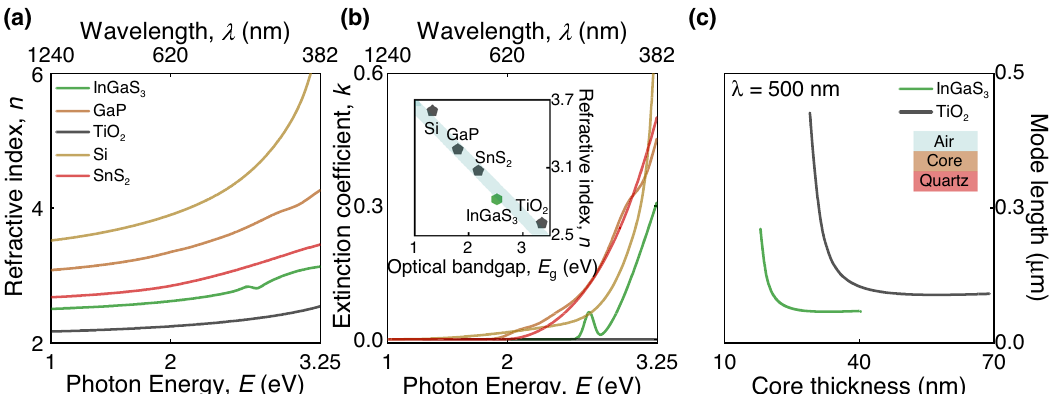
Fig. 4 Towards visible-range all-dielectric nanophotonics with non-van der Waals InGaS 3 . a Refractive index and b extinction coef fi cient spectra of visible-range high-refractive index and low-loss materials. Inset: The correlation between refractive indices and optical bandgaps for high-refractive index materials. c Plots of the mode length of the fundamental mode as a function of core thickness in a planar nanophotonic waveguide with InGaS 3 and TiO 2 as core